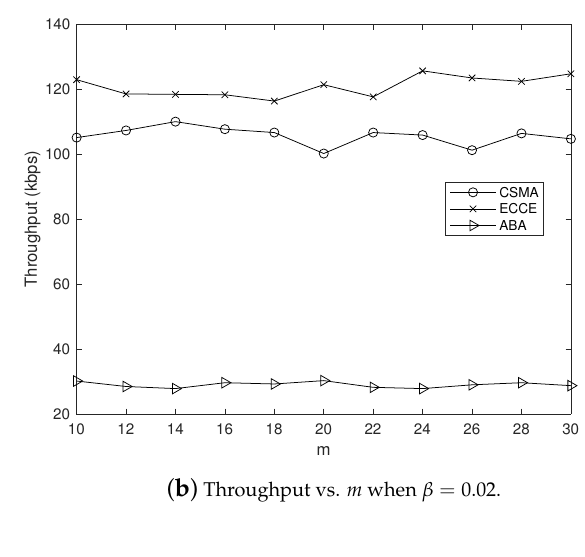
( a ) Throughput vs. m when β = 0.01.